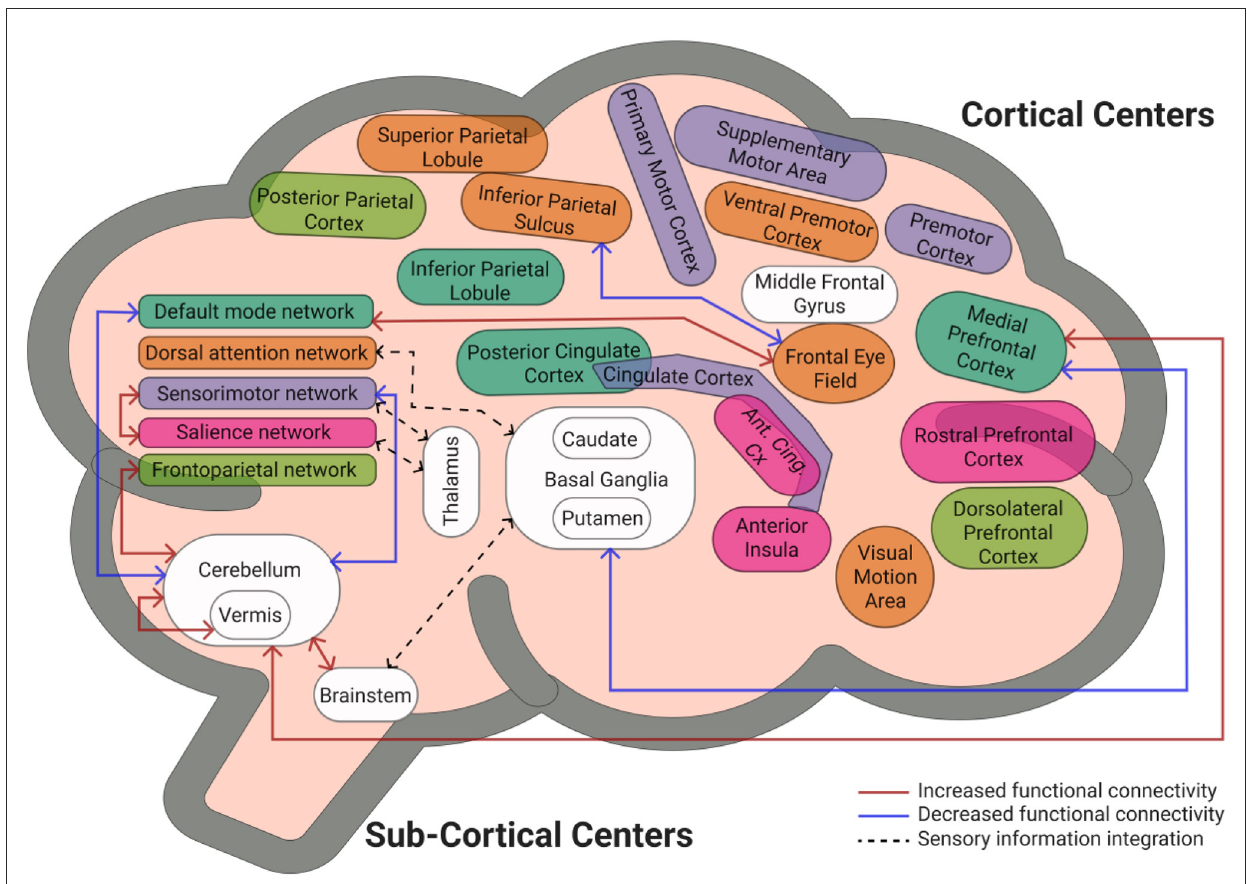
FIGURE4 Summary model representing functional connectivity patterns across brain regions and that observed within/between the cerebellum and higher cortical networks/regions. The sensorimotor and salience network along with the brainstem communicate with the thalamus and basal ganglia to integrate sensory information perceived (denoted by black dotted lines). Our results indicate that the cerebellum could be the common center for relaying this sensory information. However, at a state of cognitive pathology like mild cognitive impairment causing uninterrupted functional activation/deactivation (denoted by red, increased functional connectivity strength; blue line, decreased/weakened functional connectivity), there is limited resources available for generating an “error signal” to even identify/perceive a balance loss and delay information